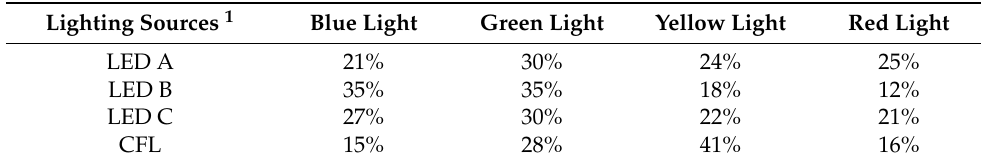
Figure 1. Comparison of spectrum readings of the three light emitting diode bulbs and one compact fluorescent lamp used in this study. LED, light emitting diode; The poultry sensitive curve was adapted from a previous publication [16]. Table 1. Spectrum proportion characteristics of three light emitting diode bulbs and one compact fluorescent